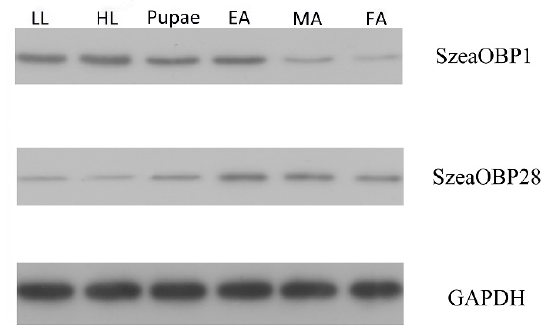
Figure 5. Protein expression patterns of the two proteins in different developmental stages. Detection of expression levels in different development stages of Sitophilus zeamais , including LL (low-instar larva, HL (high-instar larva), pupae (prepupa and postpupa), EA (eclosion adult), MA (male adult), and FA (female adult). The protein molecular weight marker is shown on the left. GAPDH was the control.